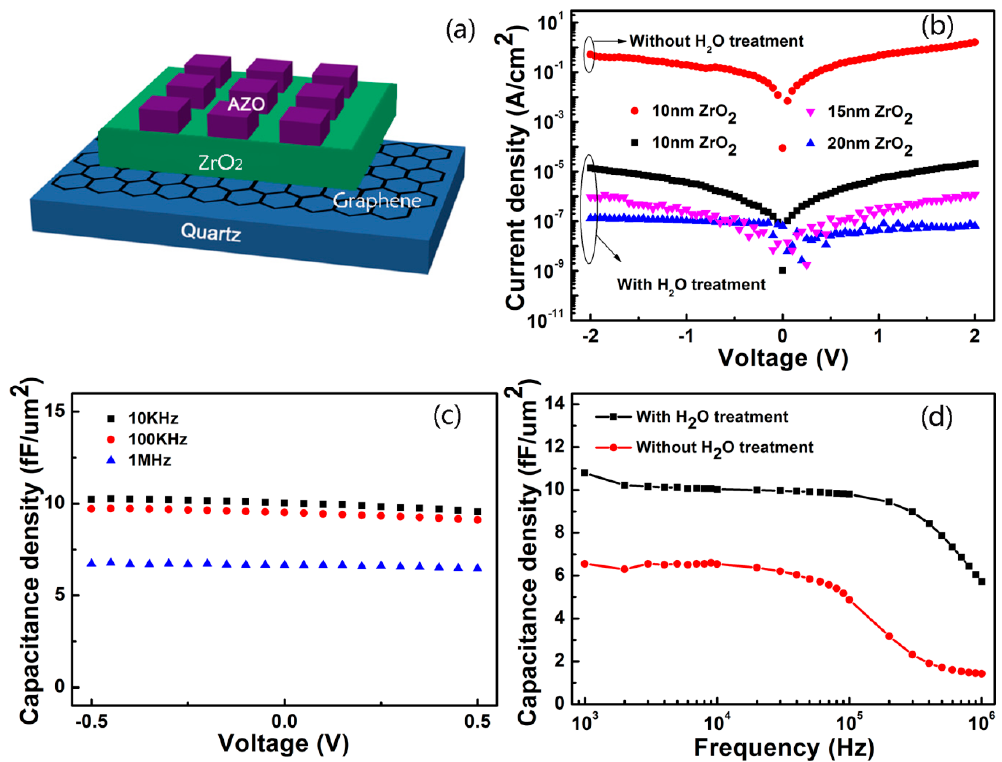
Figure 3. ( a ) A schematic diagram of the capacitors on quartz substrates; the electrical